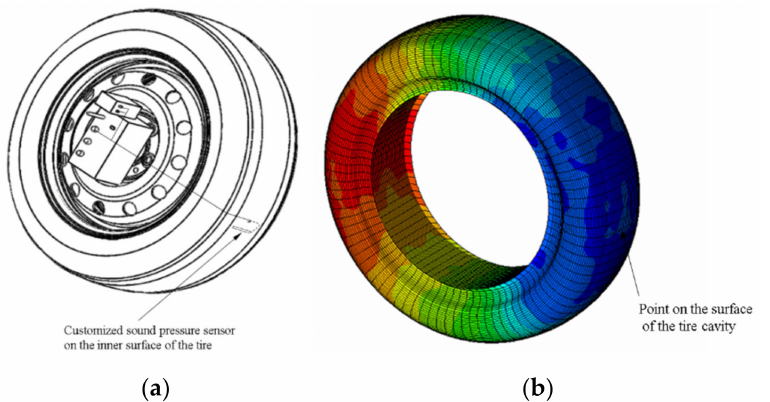
Figure 5. Position of the sensor in the test and selected point on the tire cavity finite element model: ( a ) Position of the customized sensor; ( b ) Position of the selected